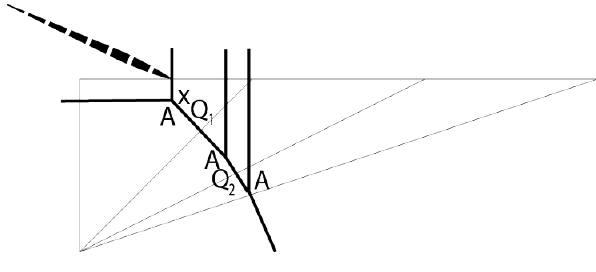
Figure 8 . The resolution of C 3 = Z 3